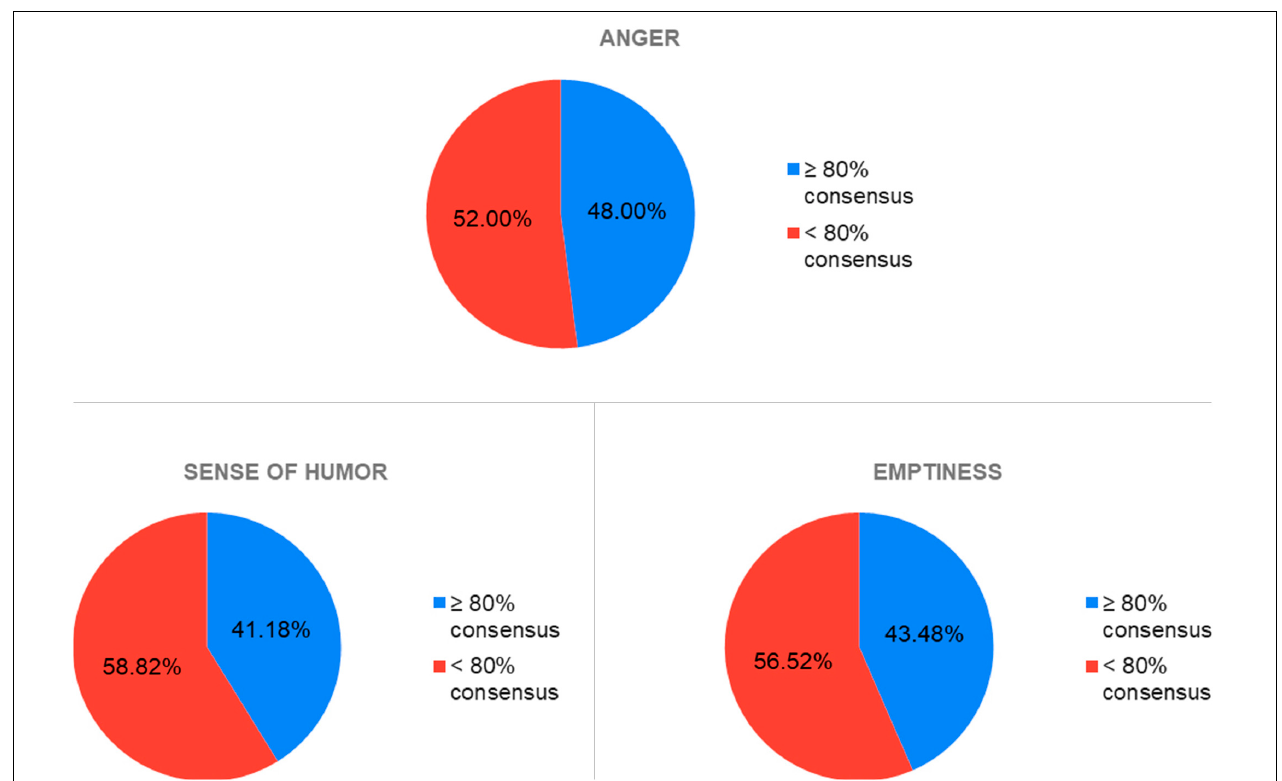
FIGURE 11 | Consensus percentages obtained for the emotions of anger, sense of humor and